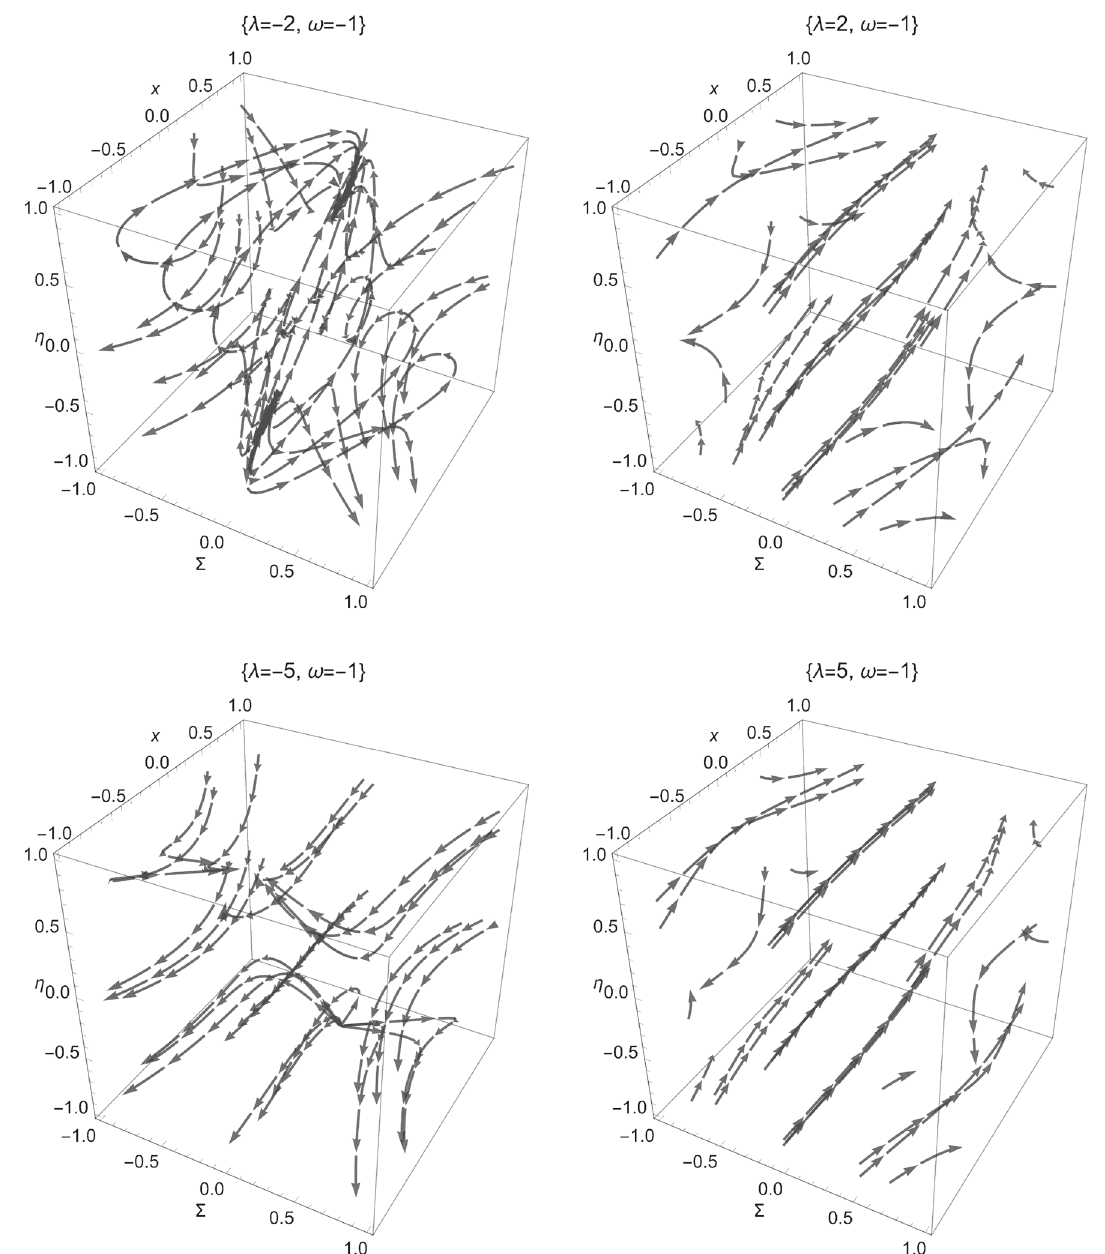
Fig. 3 Phase-space portraits for the three-dimensional dynamical sys- tem in the space ((cid:14), x ,η) for the Kantowski–Sachs spacetime and for ω = − 1. In the first row the left figure is for λ = − 2 and the right